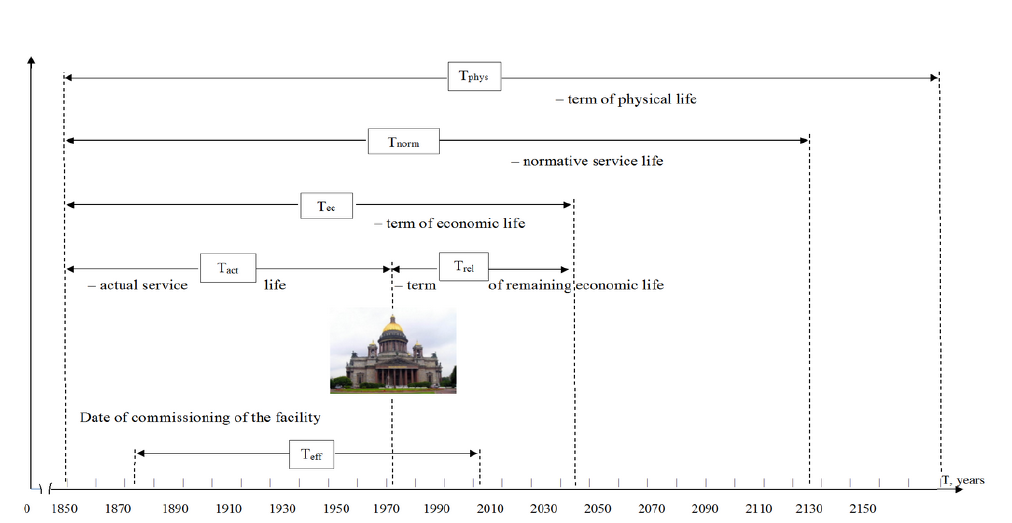
Fig. 3. Approximate time characteristics of the life cycle ( LCA ) of the real estate object in the form of an analysed BM. T eff – effective service life before major repairs of structures; T act – Actual Life of BM (developed by the